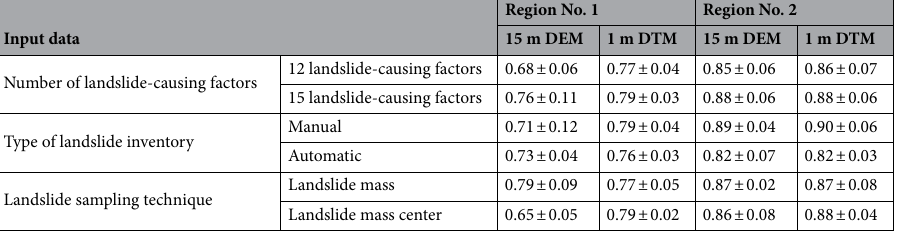
Table 2. Mean values of landslide susceptibility models overall prediction accuracy (AUC) for different input data depending on the raster resolution of topographic data. Mean values with standard deviation.